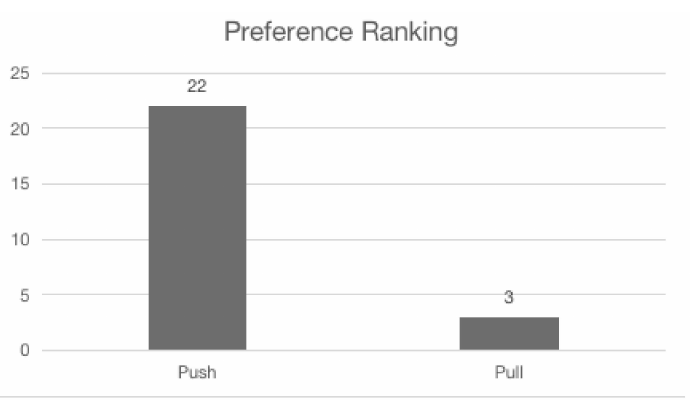
Figure 4. Preference ranking of agent’s